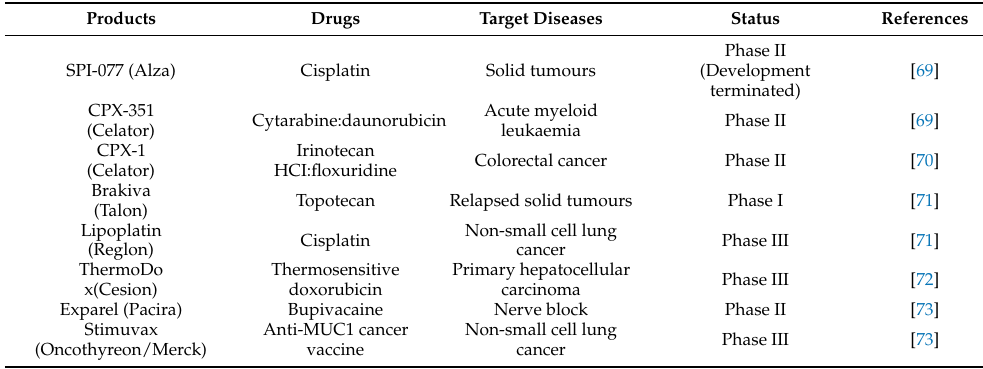
Table 6. Marketed lipid-based products in clinical development.